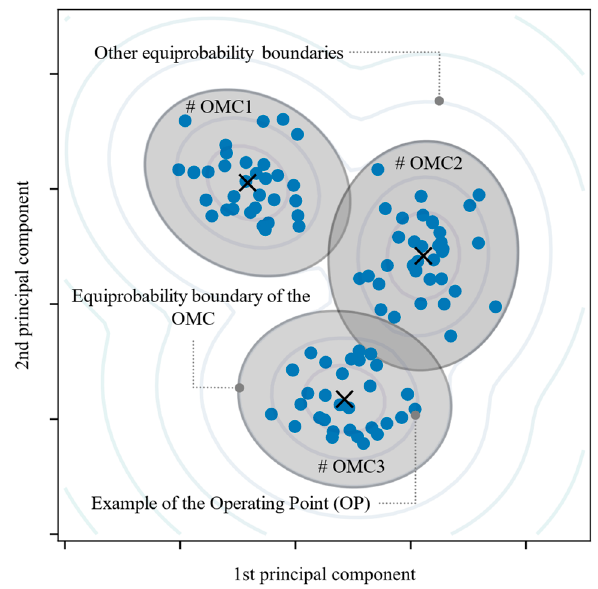
Figure 3. Example of three patterns formed by OPs (operation modes) and approximated by three Gaussian distributions bounded by equiprobability boundaries (operation mode clusters).